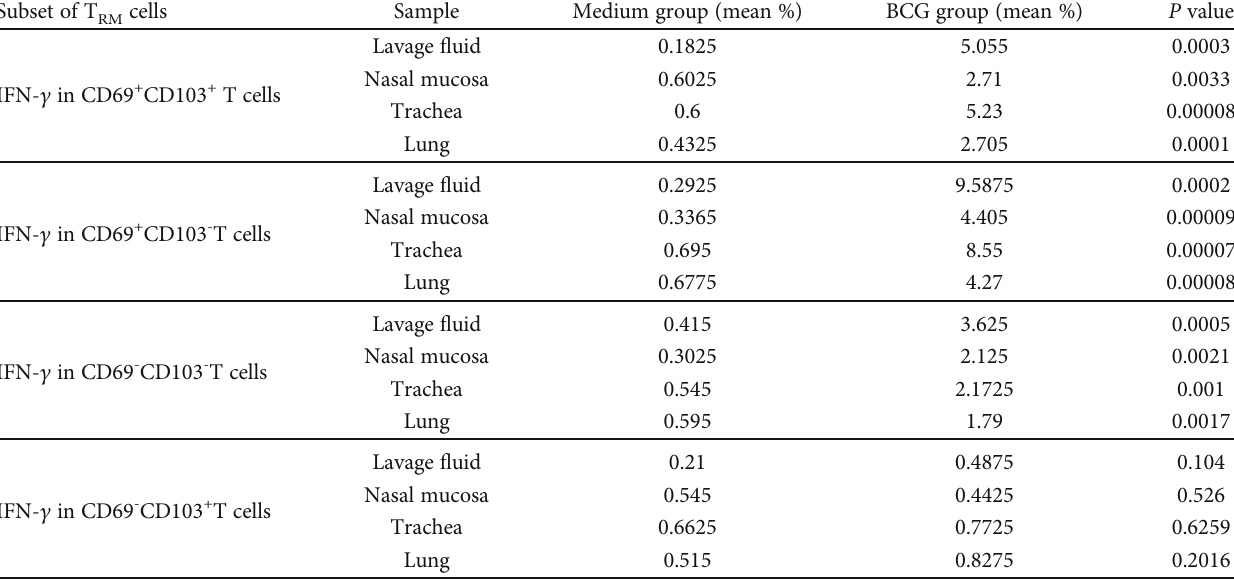
subsets of respiratory tissues before and after immunization. RM